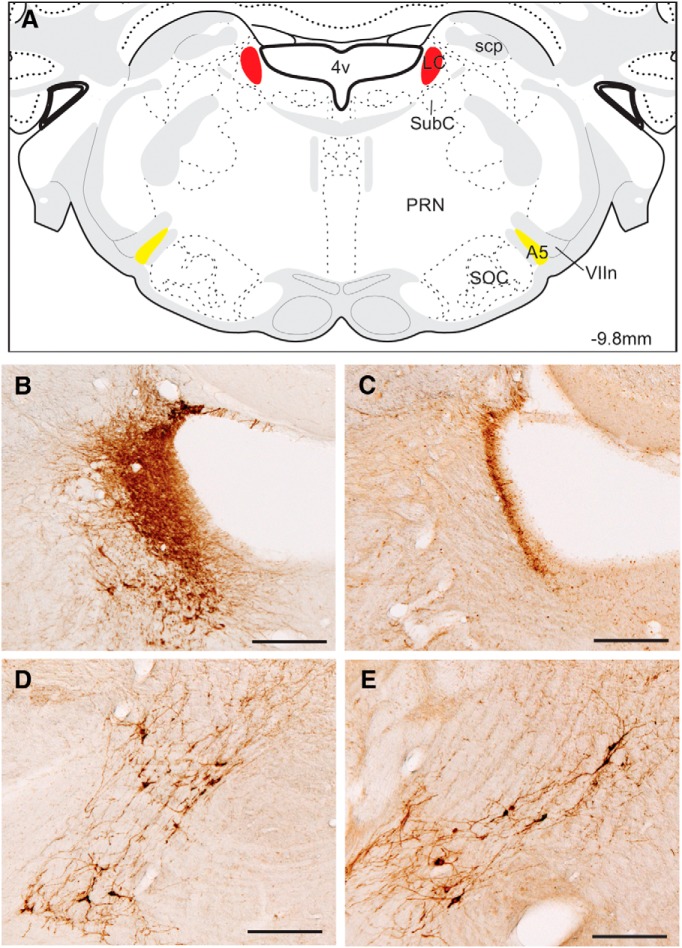
Characterization of DBH-SAP lesions. A, Schematic showing location of LC NE neurons targeted by DBH-SAP infusions (red) and the more ventrally located A5 noradrenergic neurons (yellow). B, DBH immunostaining of the LC in a Sham-injected rat shows densely-packed NE neurons, which were destroyed following DBH-SAP injections (C). By contrast, A5 neurons were intact in both Sham (D) and DBH-SAP-injected rats (E). 4v, Forth ventricle; A5, A5 NE group; PRN, pontine reticular nucleus; scp, superior cerebellar peduncle, SOC, superior olivary complex; SubC, subcoeruleus; VIIn, facial nerve. Scale bar, 200 μm. Adapted from Swanson (2004).